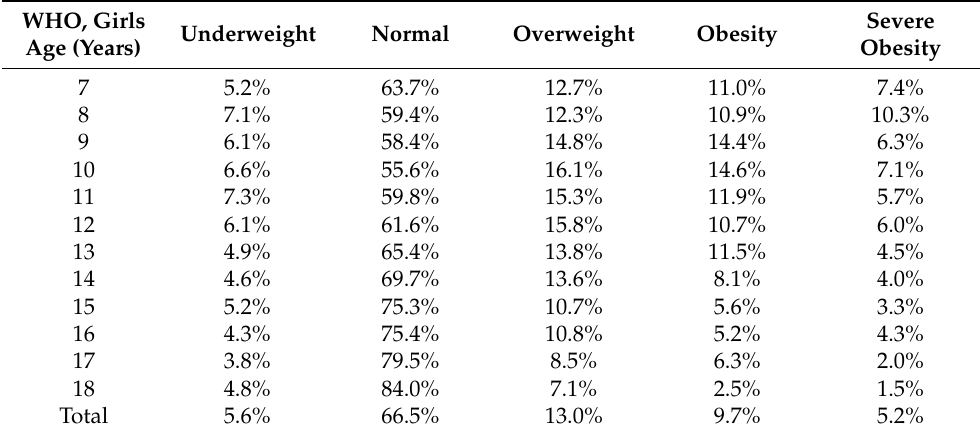
Table 4. Underweight, overweight and obesity prevalence in girls, according to age, using WHO percentile reference.